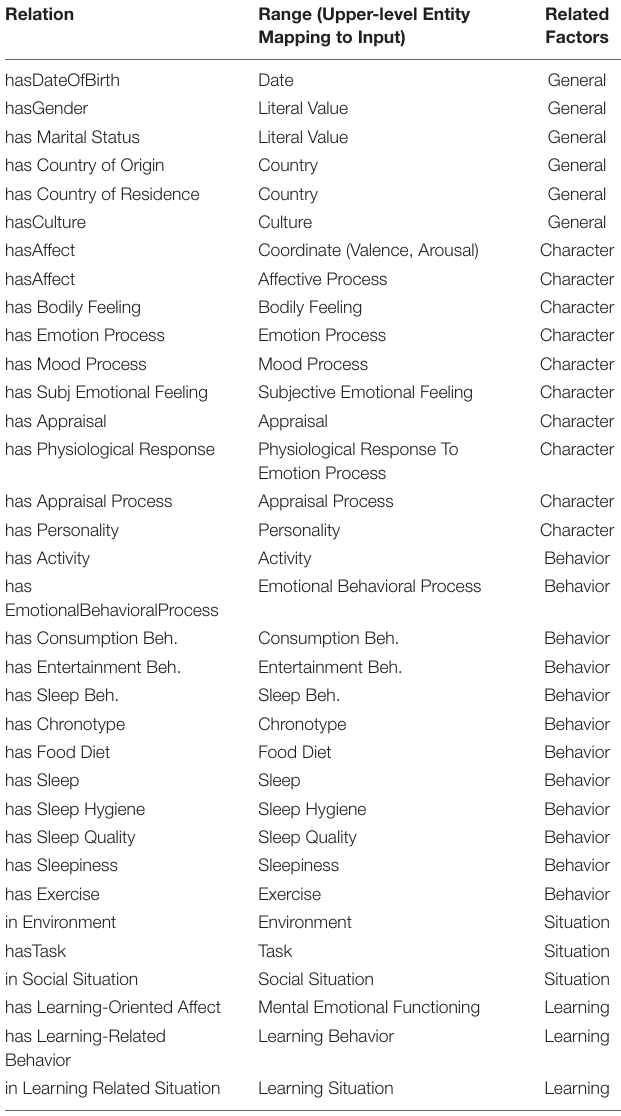
TABLE 2 | Overview of the main relations mapping between uncategorized input and hierarchical factors within the